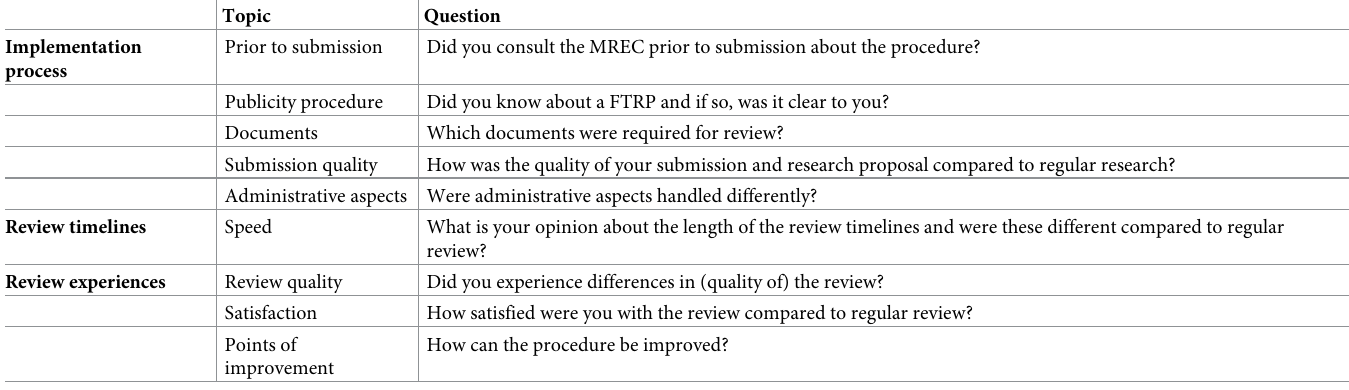
Table 3. Topic list interviews